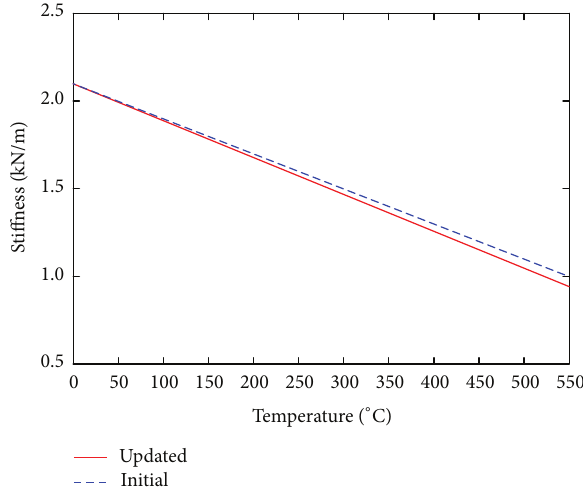
Figure 14: Temperature-dependent stiffness of the long rod.